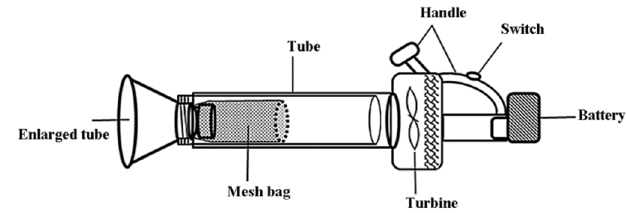
Figure 2. The structure of suction machine.